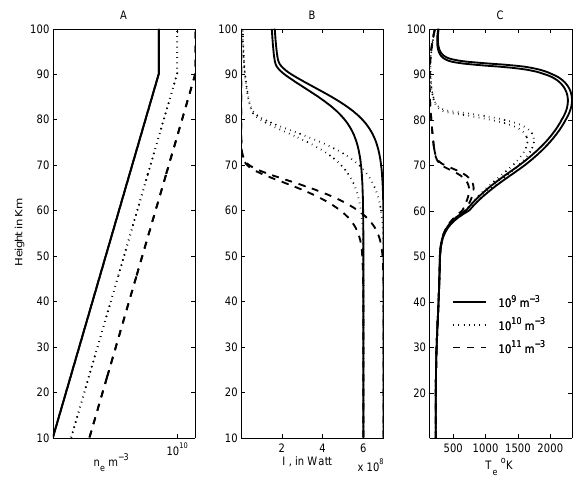
Fig. 1. The heated electron temperature T e, hot as a function of height for different smooth electron density height profiles (Eq. (4)) is shown in (C) . The electron density (A) is given by Eq. (4), and n e at height 90km is given in the legend. The scale height is H = 6km. We have used a heater frequency f = 5MHz. Two val- ues for the ERP=600 and 700MW have been used, with the higher heating corresponding to ERP=700 MW. The intensity of the heater wave as a function of height is given in (B)